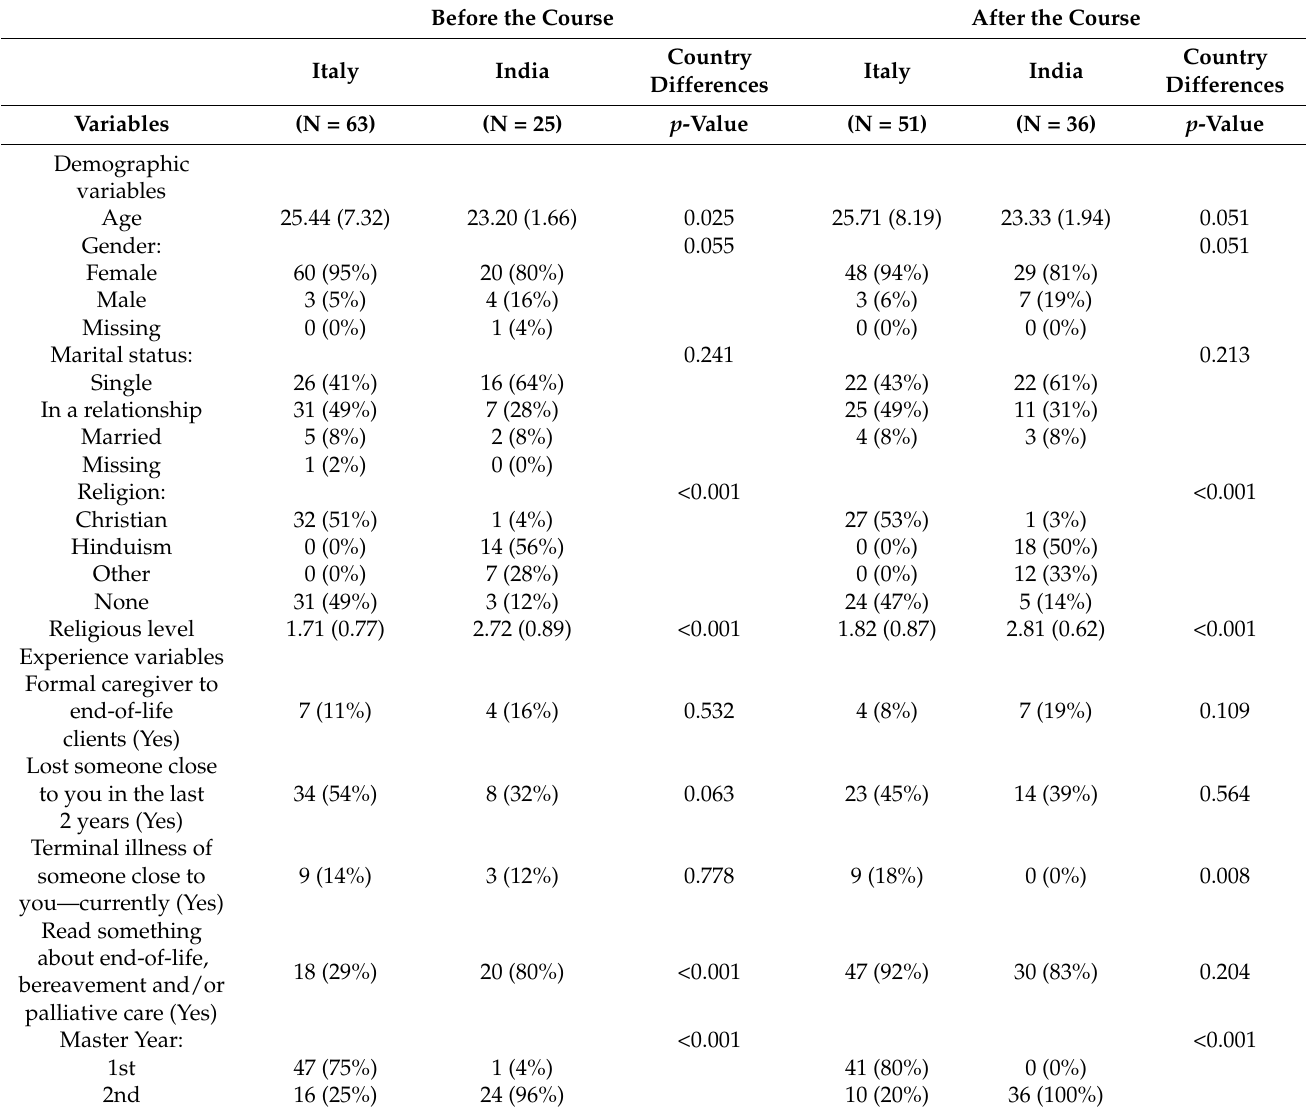
Table 1. Country differences before and after the